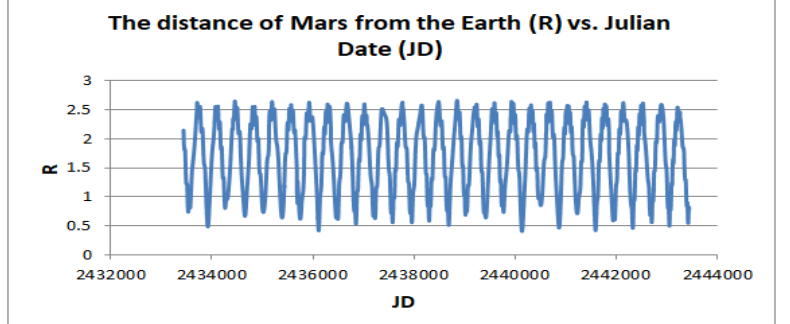
Figure 4: The change of the Mars distance from the Earth with Julia date during 10000